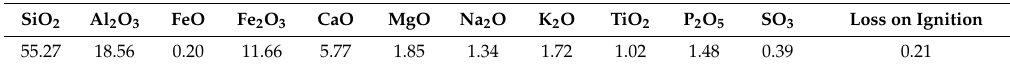
Table 4. Chemical composition of steel-slag material (%).